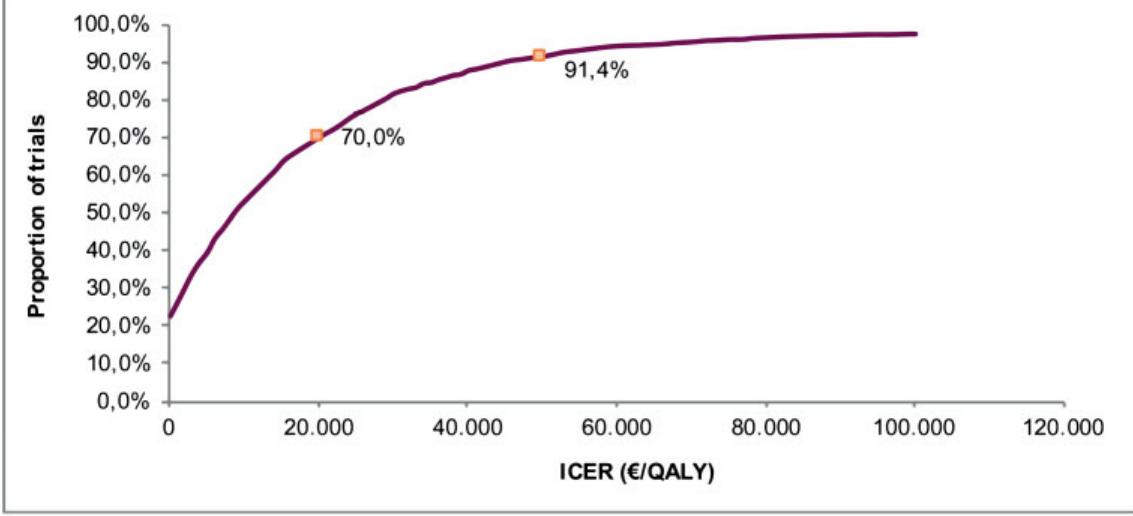
TH Open Vol. 2 No.